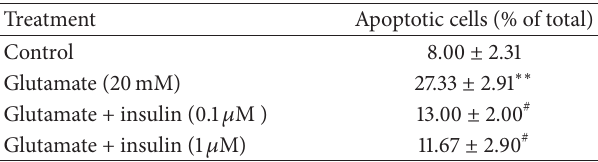
Table 2: Effect of treatments on cell viability in differentiated SH- SY5Y cells in the presence of glutamate (20 mM).